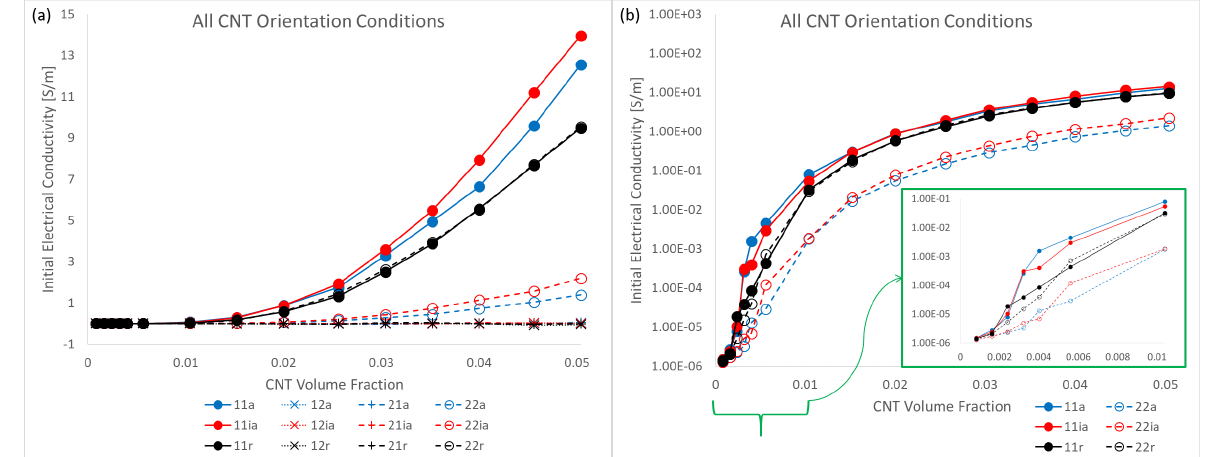
Figure 20. ( a ) Mean of all initial electrical conductivity terms Σ ij for all three orientation conditions and ( b ) mean of only Σ 11 and Σ 22 on a semi-log scale for all three orientation conditions. (Inset in b ) shows mean of Σ 11 and Σ 22 for volume fractions ≤